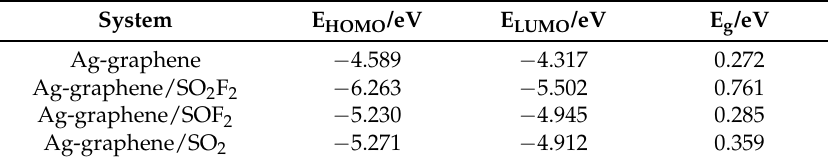
Table 4. Calculated HOMO, LUMO and HOMO-LUMO energy gap.